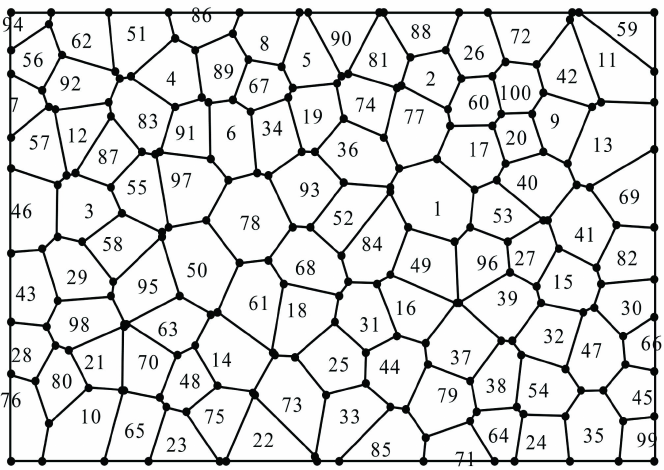
Figure 26. Voronoi diagram obtained for randomly distributed posts. The numbers shown in this figure refers to the posts and their locations. From Samaha et al.